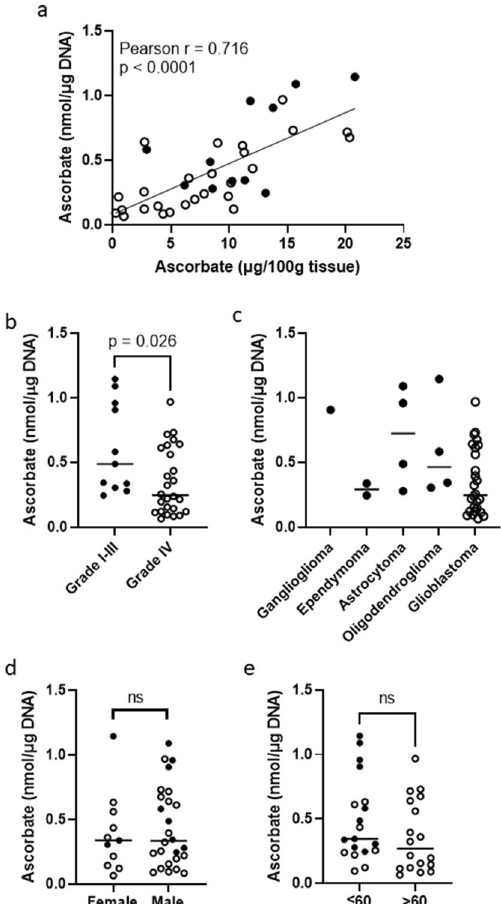
Figure 1. Ascorbate content of clinical glioma tissue from 37 patients. ( a ) Correlation between ascorbate content normalised to gDNA or normalised to tissue weight. Pearson correlation, significance indicated. ( b ) Ascorbate levels were higher in grade I-III (LGG, n = 11) than grade IV (HGG, n = 26) gliomas; unpaired two- tailed t-test. ( c ) Ascorbate levels varied across gliomas with differing subtypes, including ganglioglioma (n = 1), ependymoma (n = 2), astrocytoma (n = 4), oligodendroglioma (n = 4), and glioblastoma (n = 26). ( d ) Tumour ascorbate levels were similar in female (n = 11) and male (n = 28) patients, and ( e ) ascorbate levels did not differ by age (below (n = 19) or above (n = 18) 60 years), unpaired two-tailed t-tests. Filled circle WHO grade I–III, Open circle WHO grade IV; median is indicated by a horizontal line; ns, no